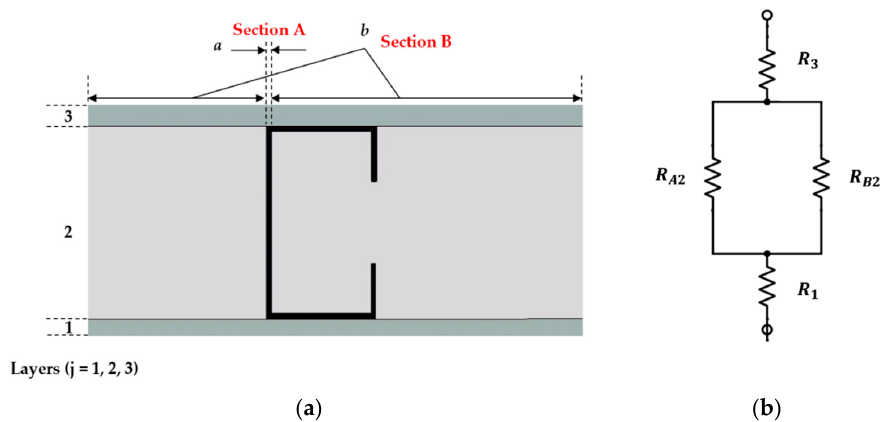
Figure 6. ( a ) Cross-section of CFS framed wall with three layers and two sections; ( b ) Equivalent series-parallel circuit. series-parallel